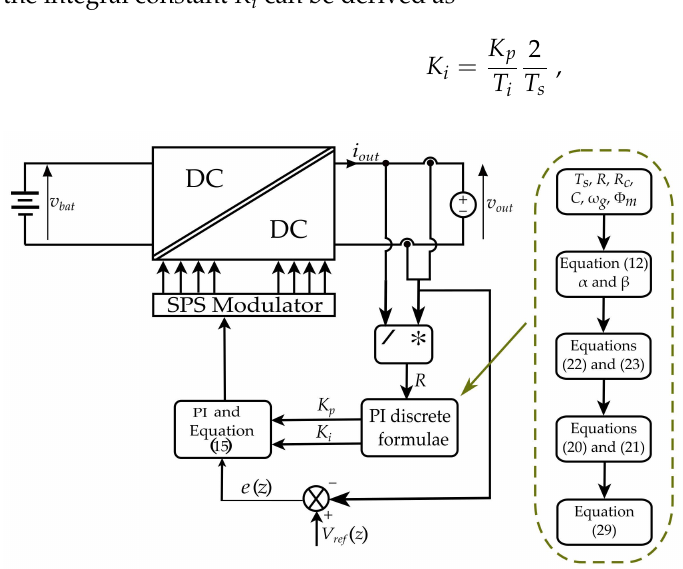
Figure 10. PLECS controller